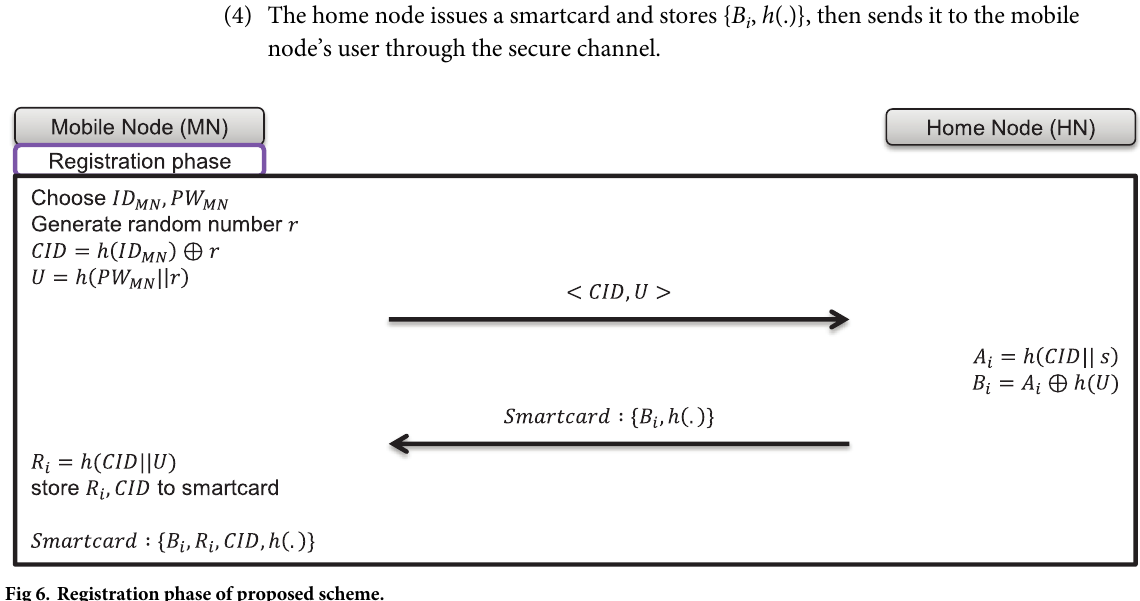
Fig 6. Registration phase of proposed